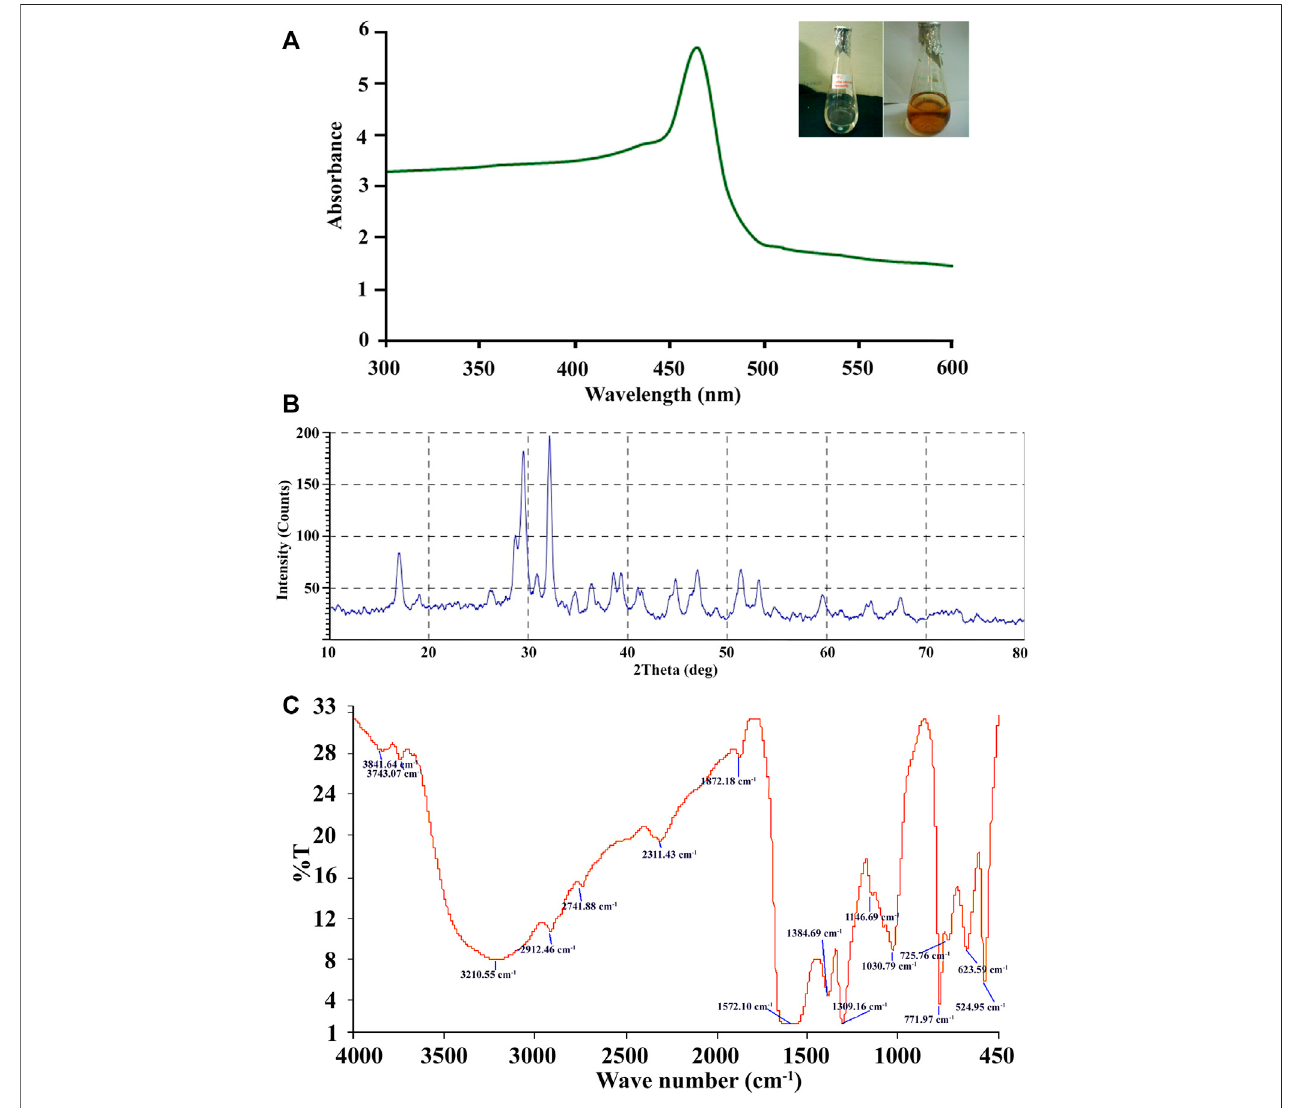
FIGURE 2 | (A – C) Biosynthesis of Ag-NPs by A. niger sap 2211 . (A) UV – Visble absorption spectra of extracellularly synthesized Ag-NPs at 460 nm. (B) XRD pattern of silver nanoparticles obtained from cell fi ltrate of A. niger sap 2211 . (C) FTIR spectrum showing associated functional group in Ag-NPs.